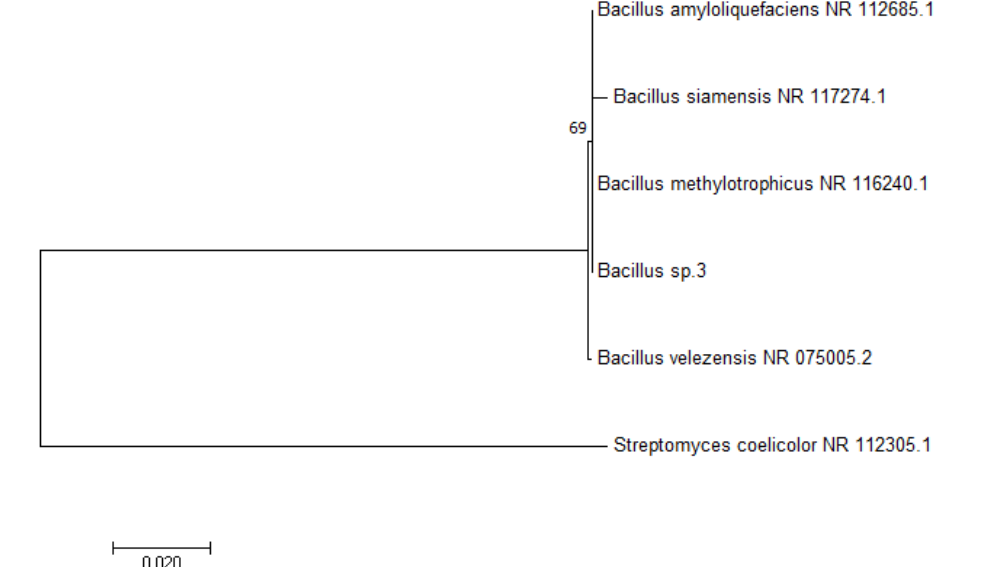
Figure 1. Molecular phylogenetic analysis of the Bacillus IP22 (in the figure marked as Bacillus sp.3) 16S rDNA sequence by the maximum likelihood method.